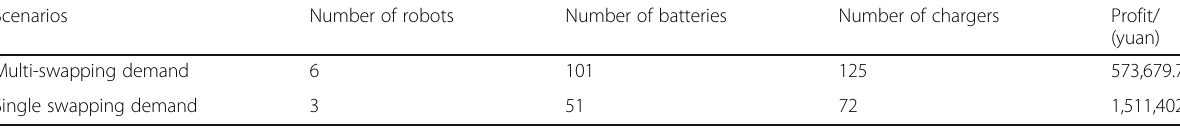
Table 7 The optimal configuration solutions under different scenarios Scenarios Number of robots Number of batteries